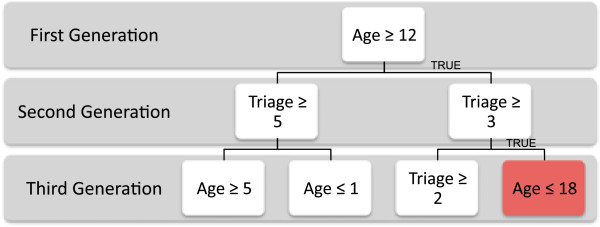
An example of a full Surveillance Tree before pruning. This is the tree representation of the partitioning from Figure 2. The node which describes the region of the hotspot is shaded in red.